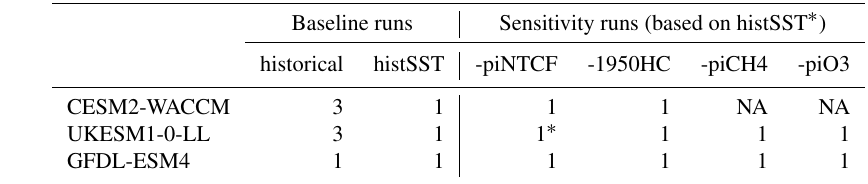
Table 2. Number of ensemble members analysed from CMIP6 experiments in this study. All were transient 1850–2014 simulations with evolving land surfaces, trace species emissions, and greenhouse gas (GHG) mole fractions. Baseline historical runs had freely evolving oceans, whilst histSST runs were atmosphere-only with prescribed (observed) SSTs and sea ice. Sensitivity runs are based on histSST. The “-piNTCF” simulation held emissions of all NTCFs (aerosols, their precursors, and tropospheric ozone precursors) at PI levels. The “-1950HC” simulation held halocarbon mole fractions at 1950 levels (essentially PI levels). The “-piCH4” simulation held methane mole fractions at PI levels. The “-piO3” simulation held anthropogenic tropospheric ozone precursor emissions at PI levels.